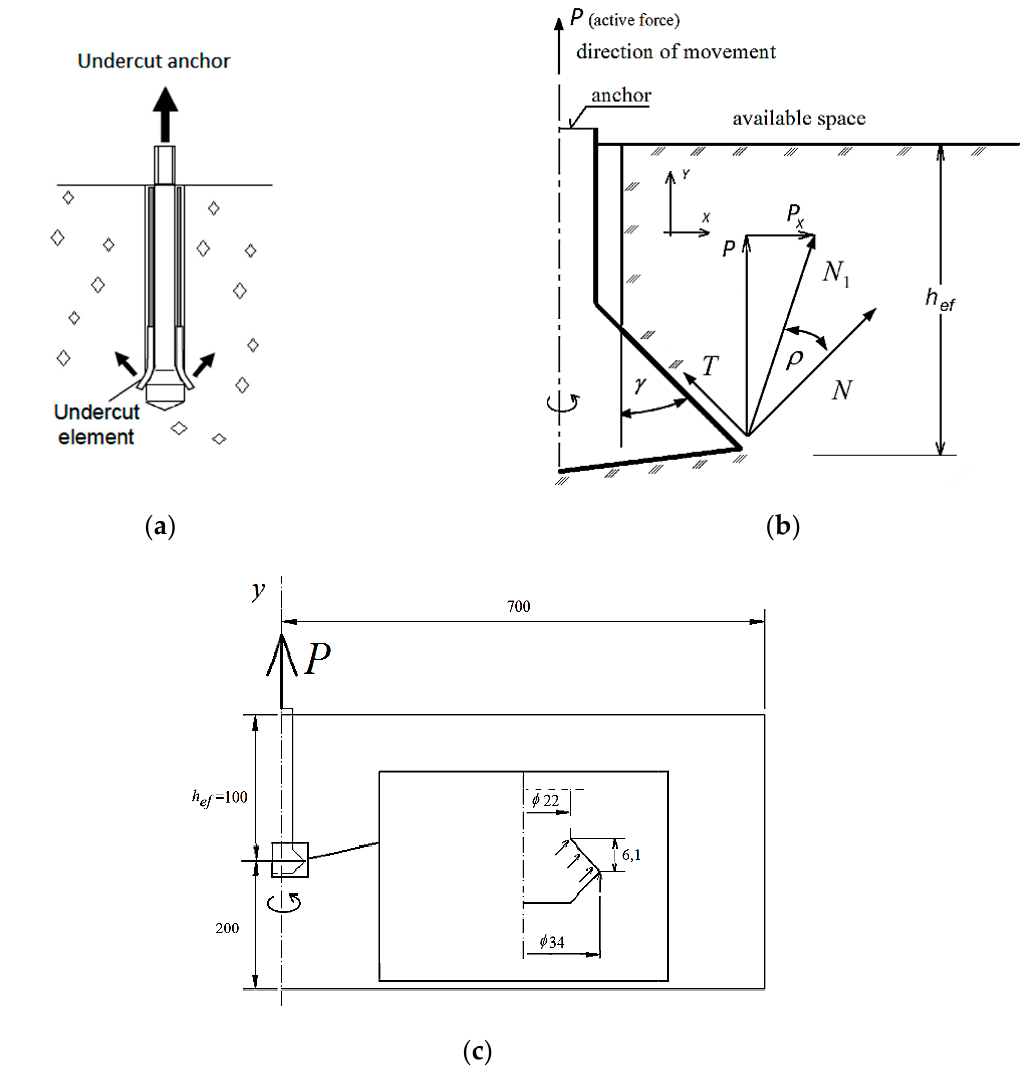
Figure 1. ( a – c ) 3D model of a single-anchor fastener.